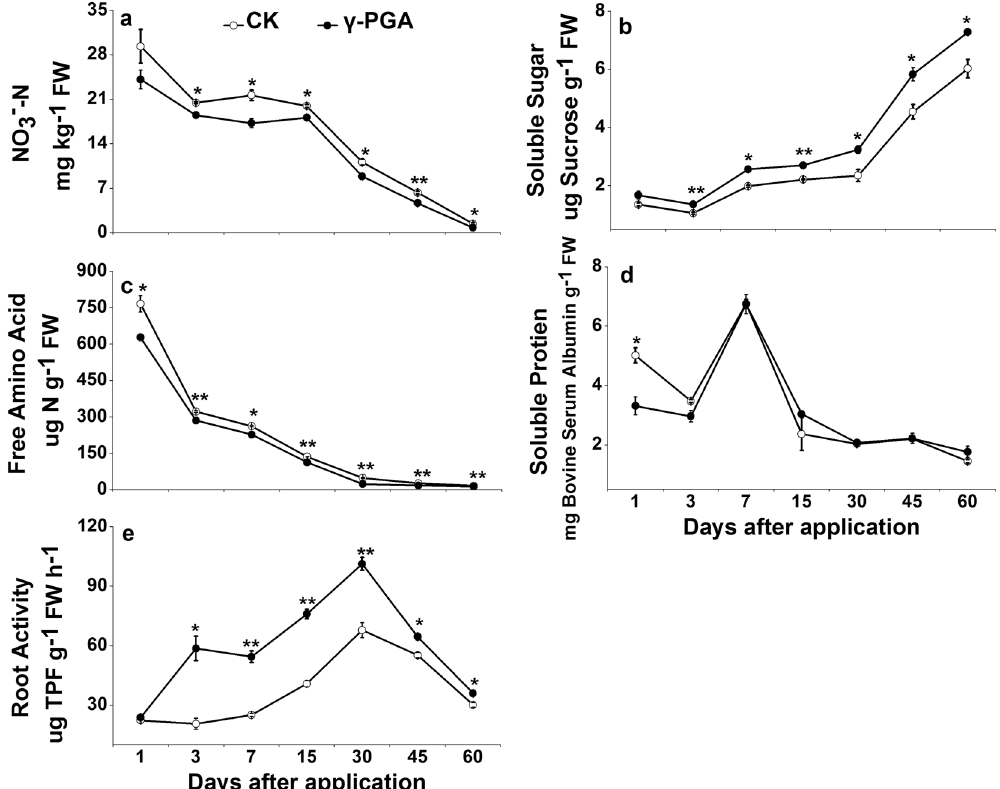
Figure 2. Temporal variations of shoot NO 3 − -N ( a ), soluble sugar ( b ), free amino acid ( c ) and soluble protein ( d ) and root activity ( e ) of the Pakchoi. Error bars represent standard error (n = 3). CK: Normal fertilization with no γ -PGA application, γ -PGA: Normal fertilization with application of 350.44 mg γ -PGA kg − 1 soil. ** p < 0.01, * p <